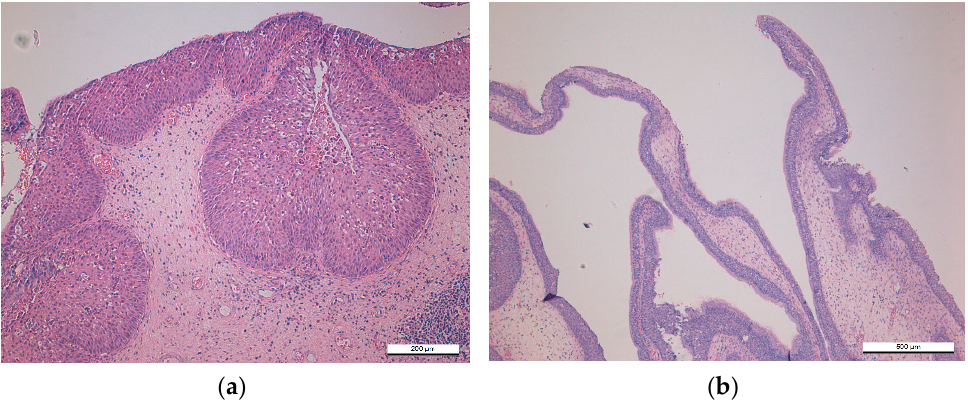
Figure 2. Two different histological types of sinonasal squamous cell papillomas (SNP): ( a ) sinonasal inverted papilloma (SNIP); ( b ) sinonasal exophytic papilloma